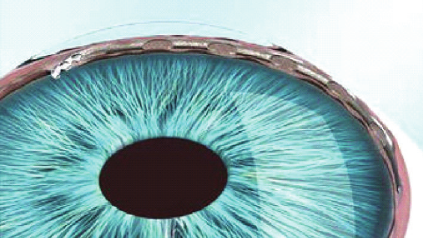
Figure 6: Hydrus scaffold design and